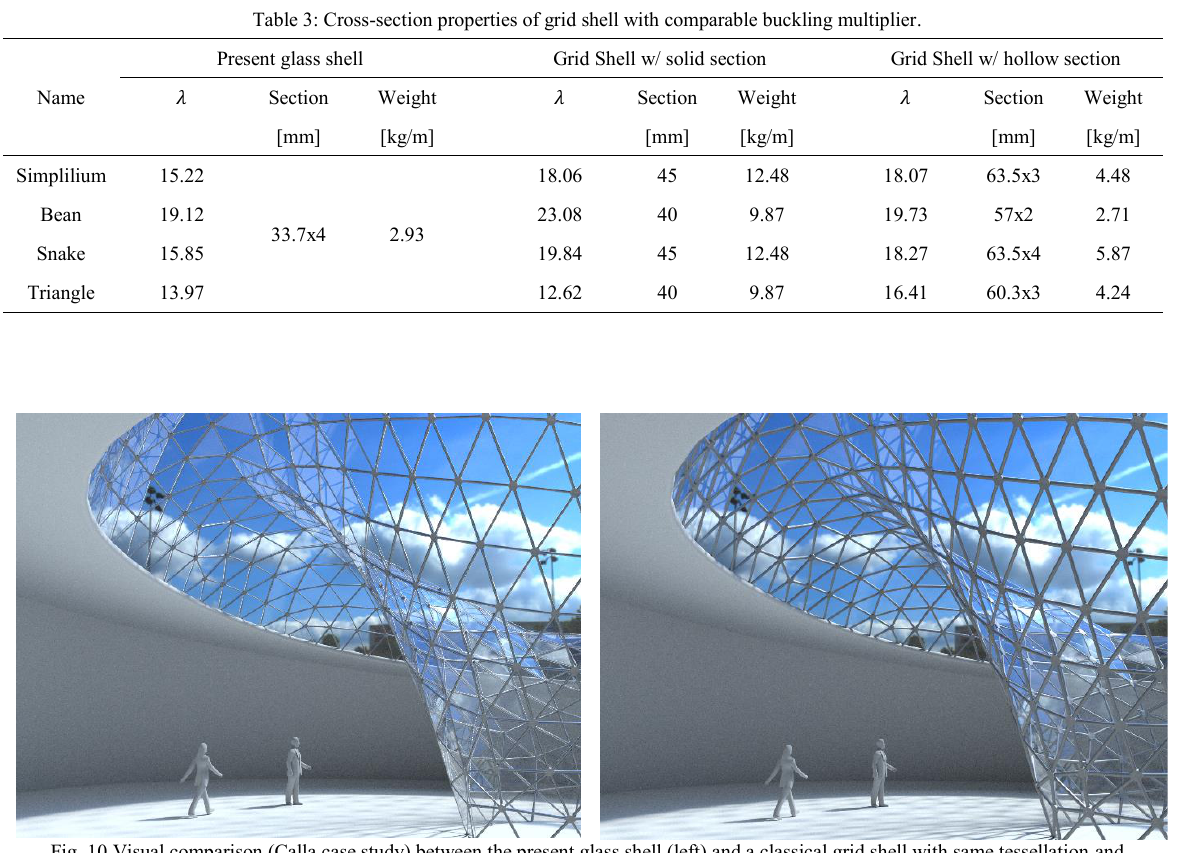
Fig. 10 Visual comparison (Calla case study) between the present glass shell (left) and a classical grid shell with same tessellation and comparable buckling factor (right). Hollow steel beams of 63.5mm outer diameter and 4mm thickness are used for the grid shell (double section size and